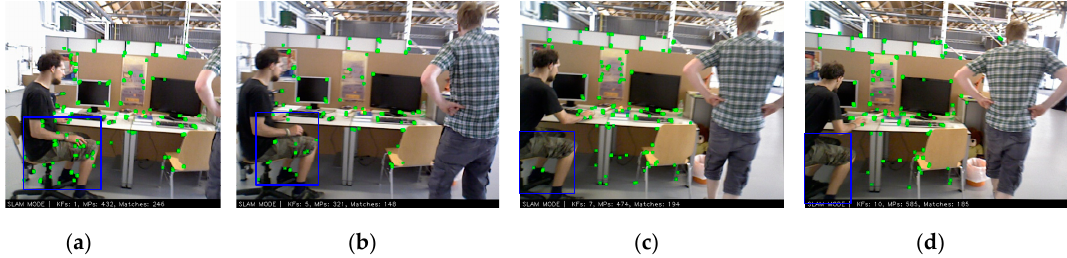
Figure 9. The order is ( a ), ( b ), ( c ), ( d ). They indicate the tracking process of our system. Where the blue box indicates that the area changes from static to motion, deletes the map point corresponding to the region's feature point.